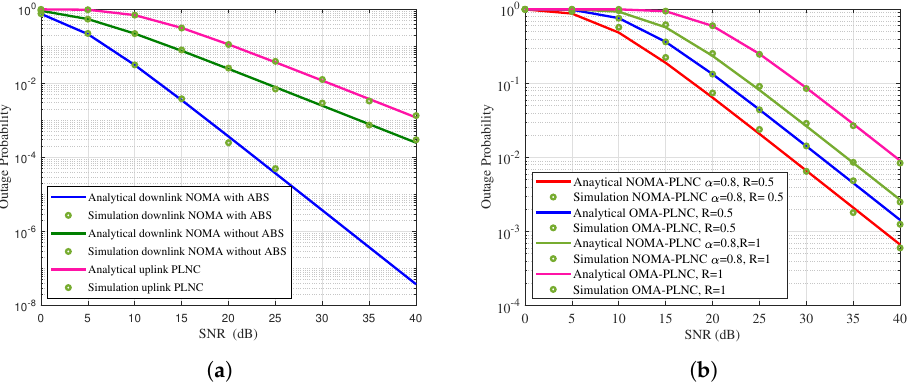
Figure 4. ( a ) Outage probabilityof the proposed network with ABS. ( b ) Outage probability of the proposed network compared with OMA.